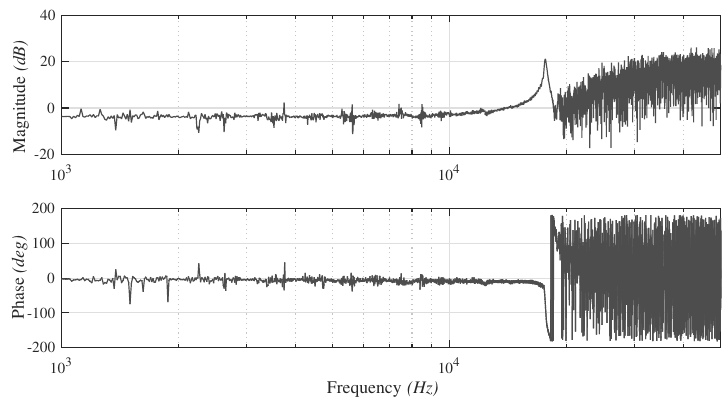
Figure 5. Frequency response of the pusher in the experimental setup.